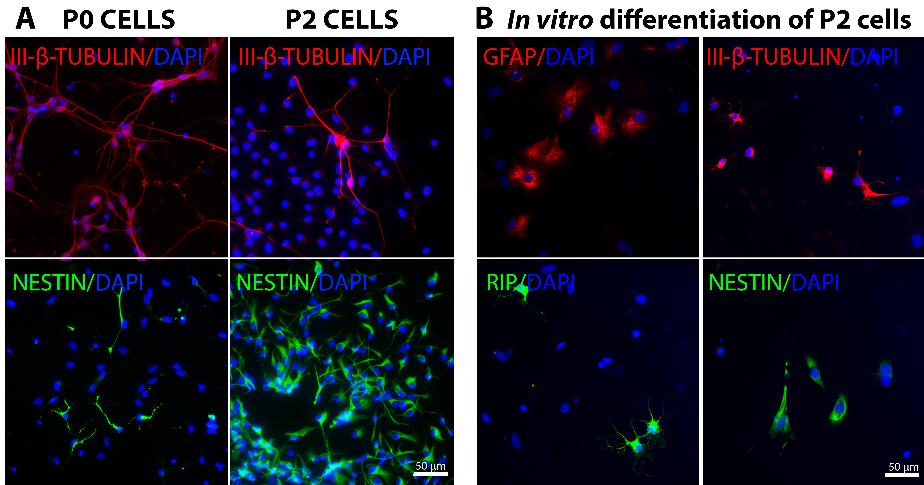
Figure 1. In vitro characterization of cells isolated from E14.5 rat embryo spinal cords. ( A ) P0 cells represent the fetal cells that were directly isolated from embryos and used for transplantation on the same day. Most P0 cells were already of neuronal lineage as shown by their positive III- β -tubulin staining (red). In addition, some Nestin-positive (green) neural progenitor cells were observed. P2 cells represent the cells that were cultured two passages to obtain pure neural progenitor cells (NPCs). Almost all cells at that time were positive for Nestin (green) showing their progenitor cell identity. However, some already differentiated neurons were also seen (red III- β -tubulin staining). DAPI (4 ′ ,6-diamidino-2-phenylindole) staining is shown in blue; ( B ) On the 12th day of culturing, some P2 cells were also seeded onto coverslips with “Differentiating medium” for in vitro differentiation experiment. On the 6th day of differentiation, most of the cells had differentiated into GFAP (Glial fibrillary acidic protein)-positive astrocytes (red), with Rip-positive oligodendrocytes (green) and III- β -tubulin-positive neurons (red) also observed. The presence of several Nestin-positive cells (green) indicates undifferentiated immature cells. DAPI staining is shown in blue.